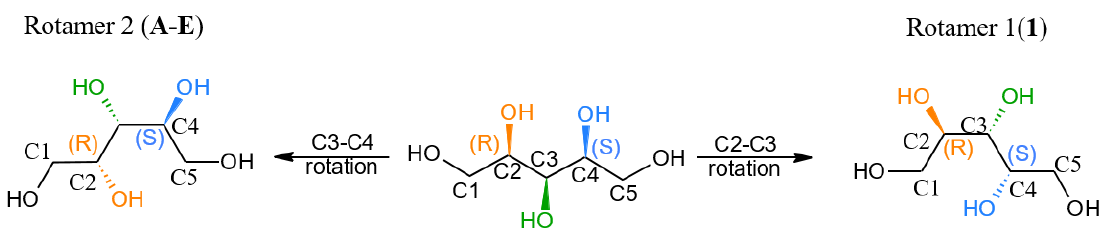
Figure 6. Molecular structures of the two rotamers of xylitol. To the best of our knowledge, Rotamer 1 is described for first time in this work ( 1 ). Rotamer 2 has been previously described (compounds A – E ).